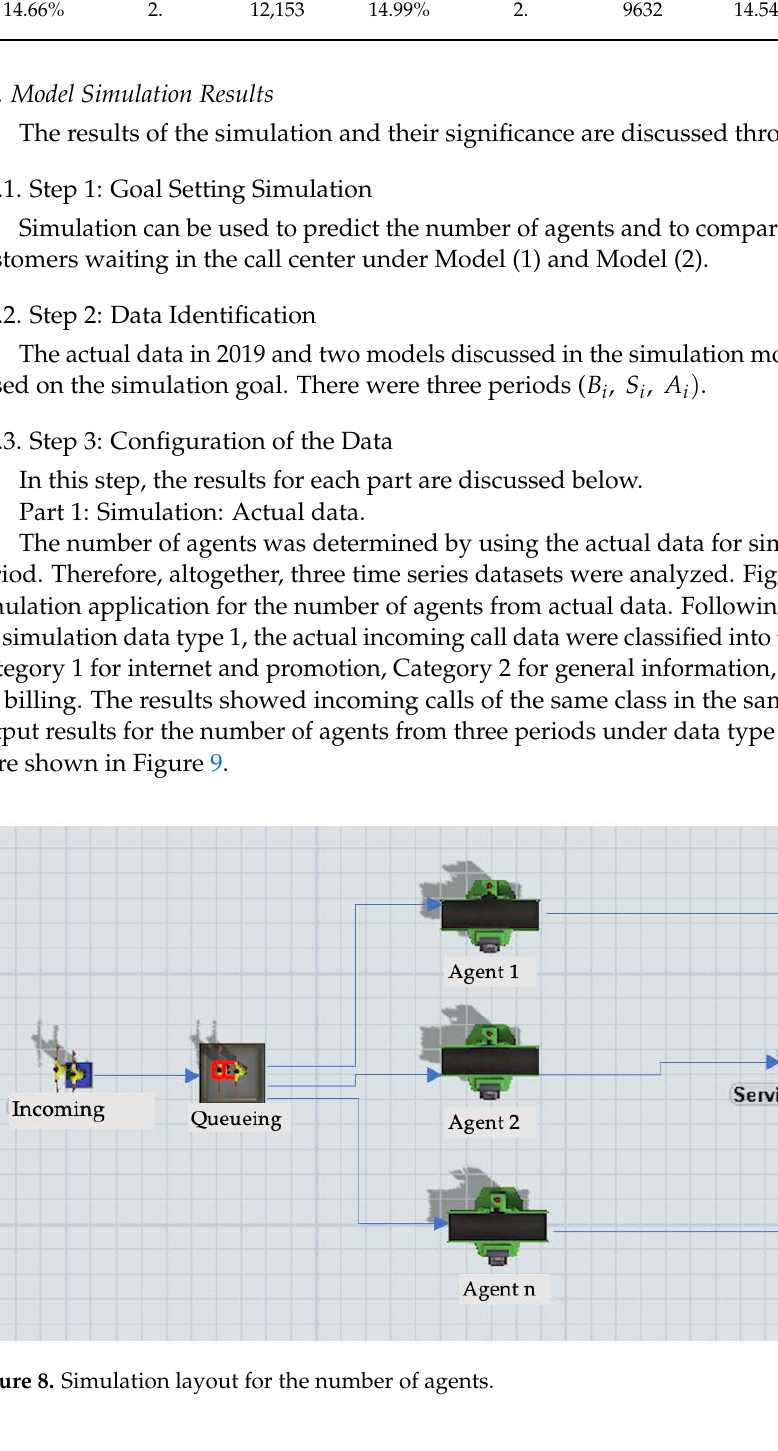
Figure 9. The number of agents from actual data of type 1 and type 2. Part 2: Simulation: Model (1) and Model (2) The previous steps consisted of using the incoming calls, average handling time and the number of agents as the input parameters in the simulation to determine the number of customers waiting in the call center. Both models were simulated, and the number of customers waiting in the call center is shown in Table 9. Table 9. The number of customers waiting in the three periods. Period